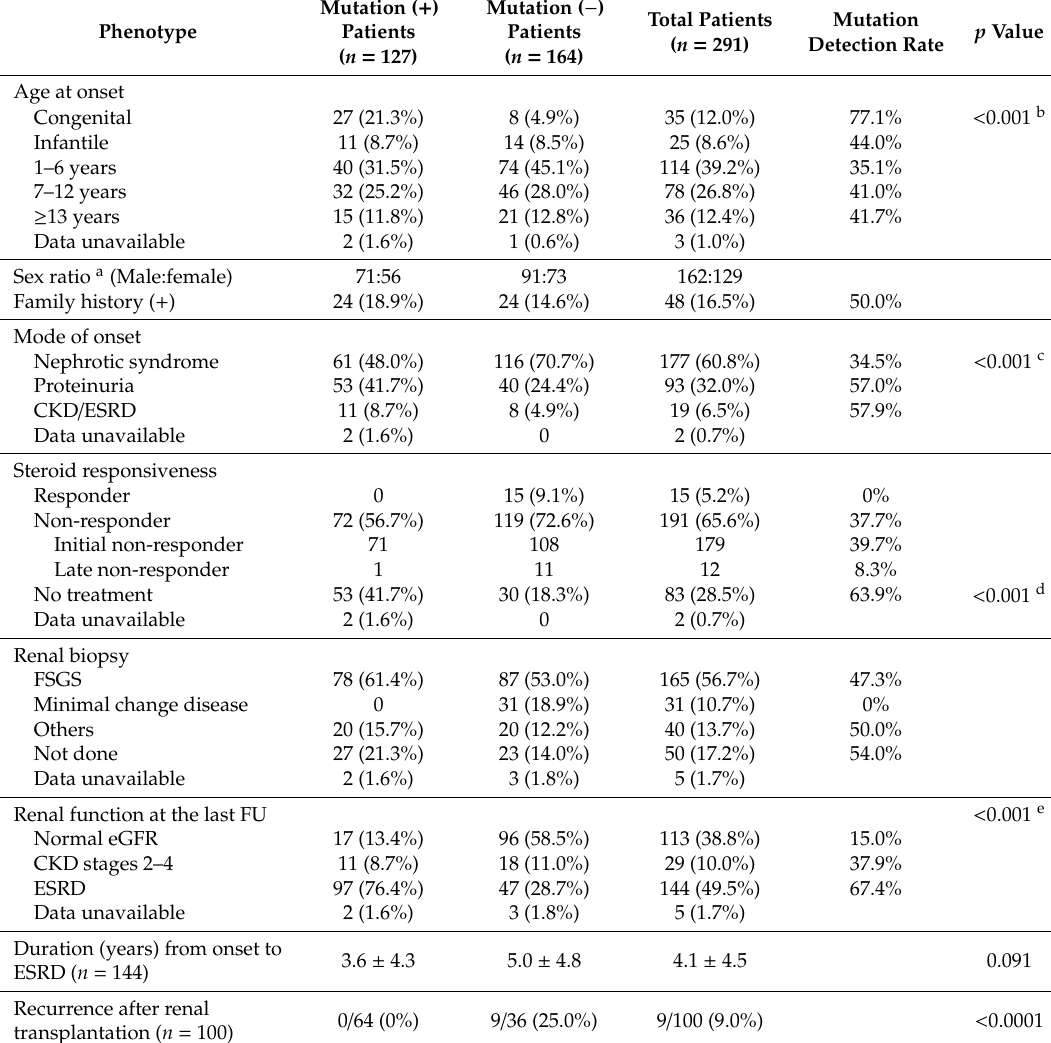
Table 1. Genotype-phenotype correlations in pediatric patients with steroid-resistant nephrotic syndrome or focal segmental